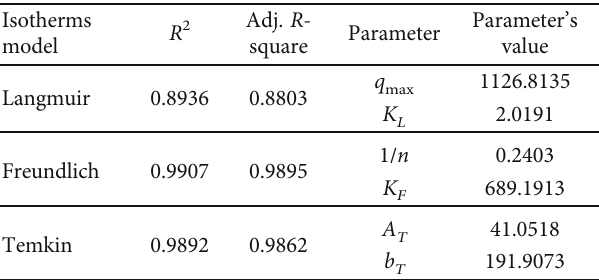
Figure 5: Langmuir, Freundlich, and Temkin isotherms for the adsorption of MB by CaFe Table 2: Isotherm parameters of CaFe adsorption.